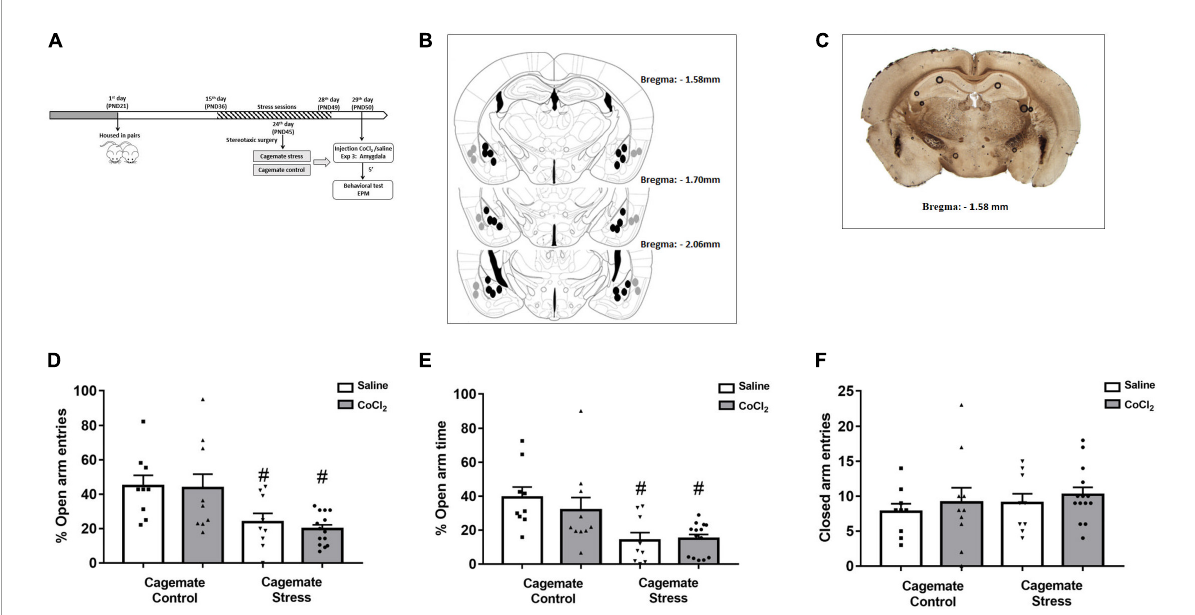
FIGURE3 (A) Schematic representation of the experimental protocol (PND, postnatal day). (B) Schematic representation and (C) photomicrographs of histological results according to the Atlas of Paxinos and Franklin (2019) in the amygdala (Amy). The black circles represent the sites of drug infusion that were on-target within the amygdala. The gray circles represent the locations in which the injection occurred outside the amygdala. The number of dots in the panel is fewer than the number of animals used because of data overlapping (Bregma: –1.58 mm). (D) Effects of microinjection in amygdala of saline or CoCl 2 (1 mM.100 nL - 1 ) in cagemates that cohabited in pairs with mice subjected to chronic restraint stress evaluated on the percentage of entry into the open arms in the EPM. (E) Effects of microinjection in amygdala of saline or CoCl 2 (1 mM.100 nL - 1 ) in cagemates that cohabited in pairs with mice subjected to chronic restraint stress evaluated on the percentage of time in open arms in the EPM. (F) Effects of microinjection in amygdala of saline or CoCl 2 (1 mM.100 nL - 1 ) in cagemates that cohabited in pairs with mice subjected to chronic restraint stress evaluated on the entry into the closed arms in the EPM. All data are presented as mean ± SEM ( n = 9–14). # p < 0.05 vs. respective cagemate control. Two-way ANOVA, followed by Duncan post-hoc